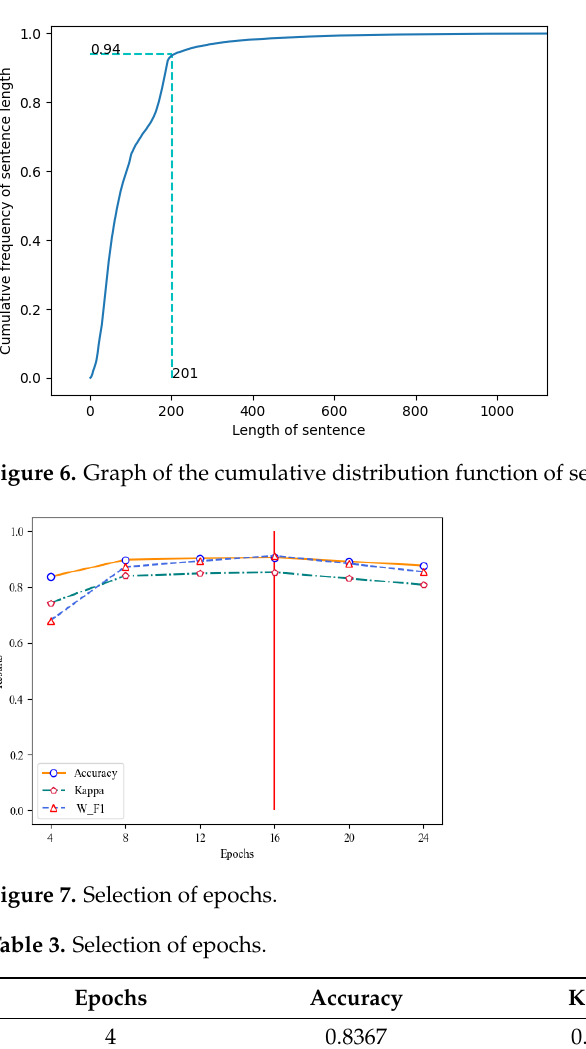
Figure 5. Sentence length and frequency statistics.